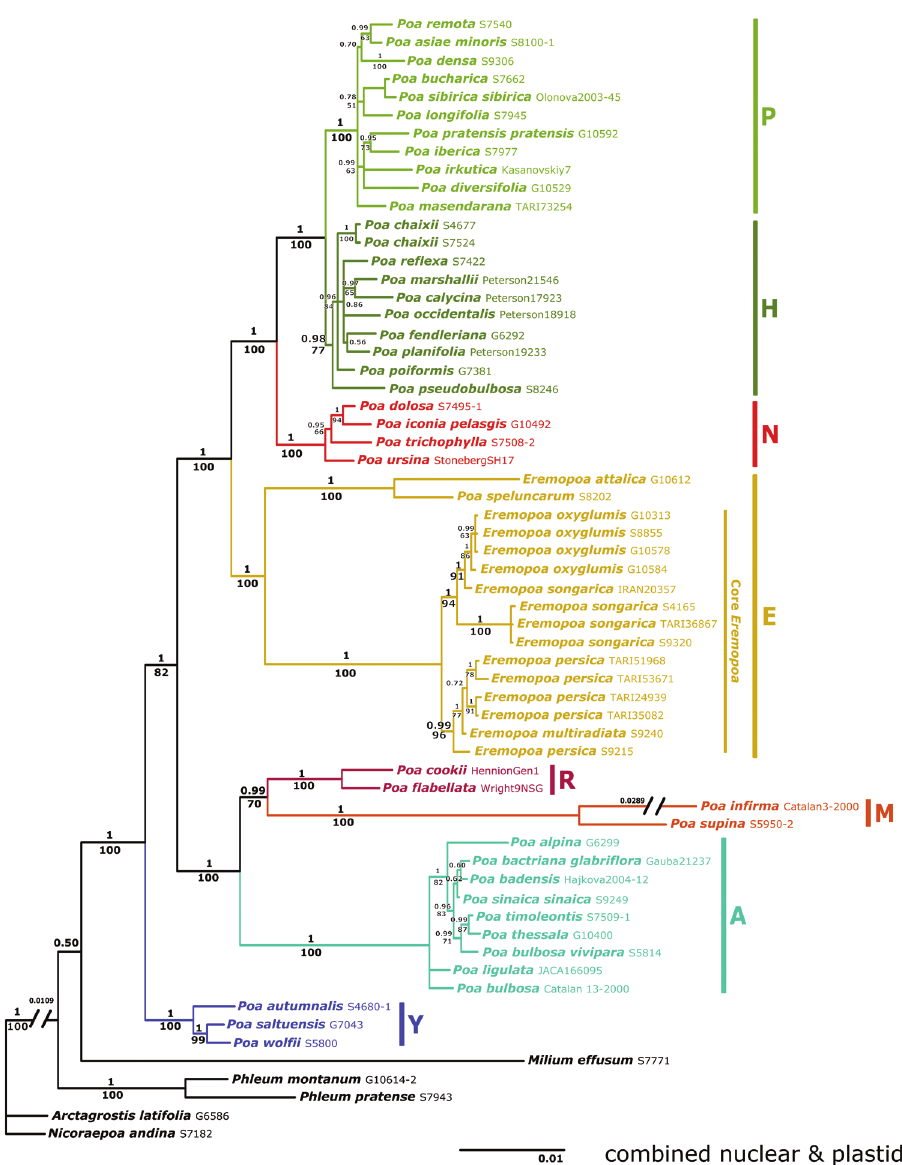
Figure 2. Poa combined nrDNA and plastid Baysian analysis showing placement of Eremopoa . Bayesian 50% majority rule consensus tree of combined nrDNA (ITS and ETS) and plastid data ( trnT-trnL-trnF, matK and rpoB-trnC ). Bayesian posterior probabilities are shown above branches, MP bootstrap values below branches. Major clades are indicated by colour and capital letter; outgroups are shown in